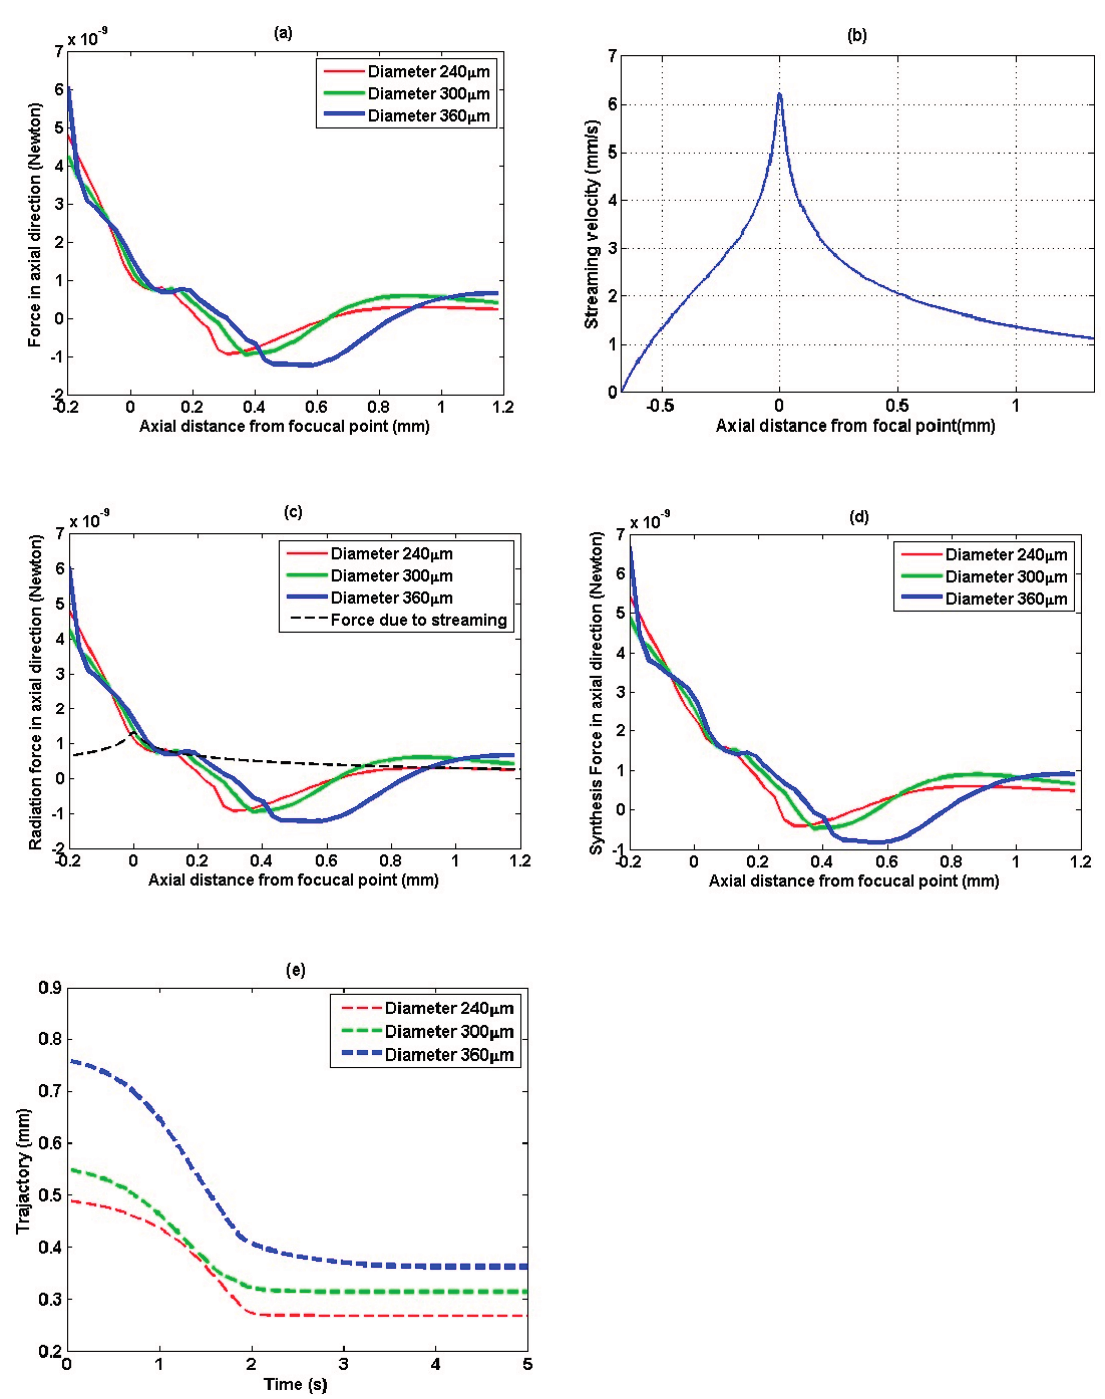
which are calculated with the consideration of lateral radiation force and the resistance of water viscosity. The initial lateral positions are 150 μ m off the beam axis and the initial speed are zero. It reveals that all the three particles can be trapped near the z -axis.